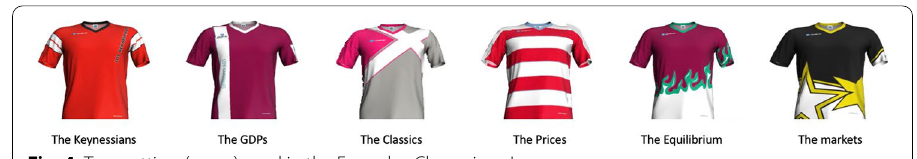
Fig. 4 Team attires (some) used in the Econplus Champions